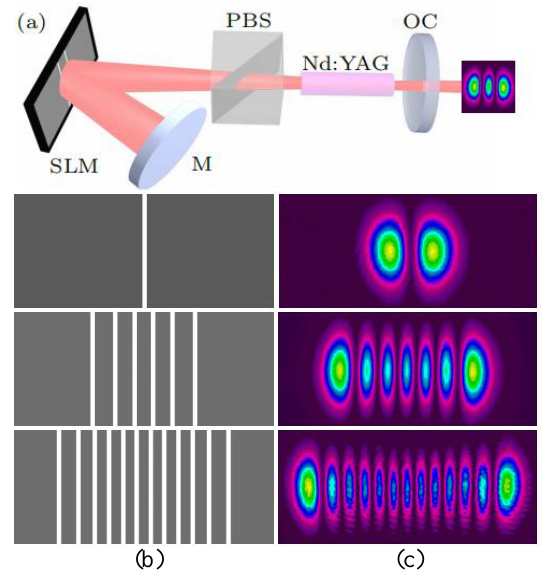
Figure 4. ( a ) Experimental configuration of the digital V-shaped laser using a SLM; ( b ) Bar-grating- shaped holograms on the SLM and ( c ) the outputs of HG 1,0 , HG 6,0 , and HG 12,0 , respectively (Adapted from an open-access source Ref. [67]).